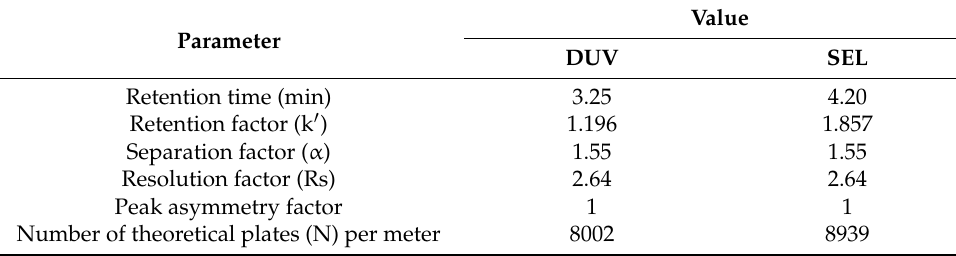
Table 2. Chromatographic parameters for DUV and SEL by the suggested HPLC-FD method. Parameter